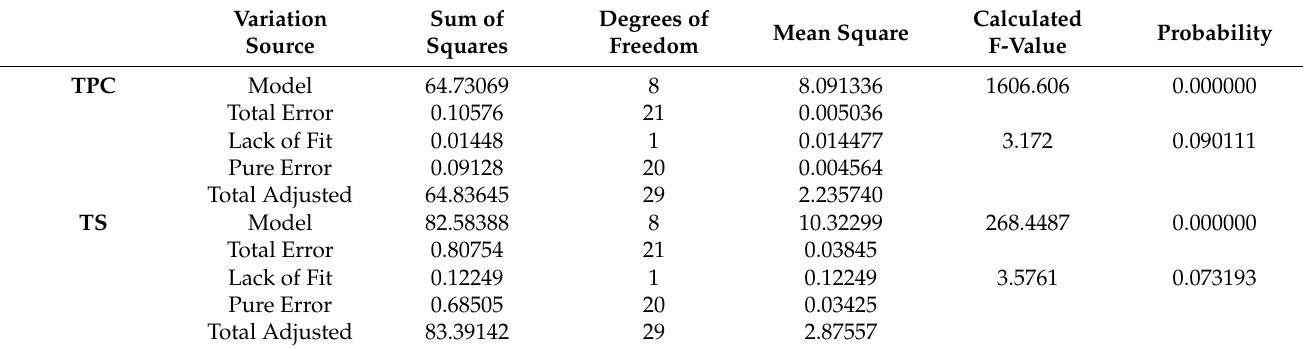
Table 3. Results of the analysis of variance (ANOVA) presenting the fitness of the cubic model estimated from simplex axial design for predicting the behavior of total phenolic compounds (TPC) and thiosulfinates (TS) for solvent